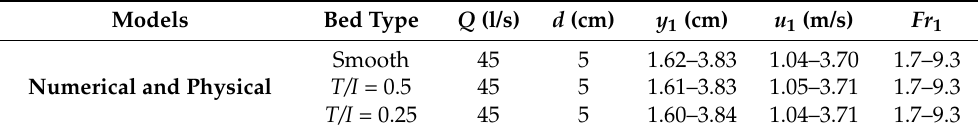
Table 3. Main flow variables for the numerical and physical models (Ahmed et al. [20]).